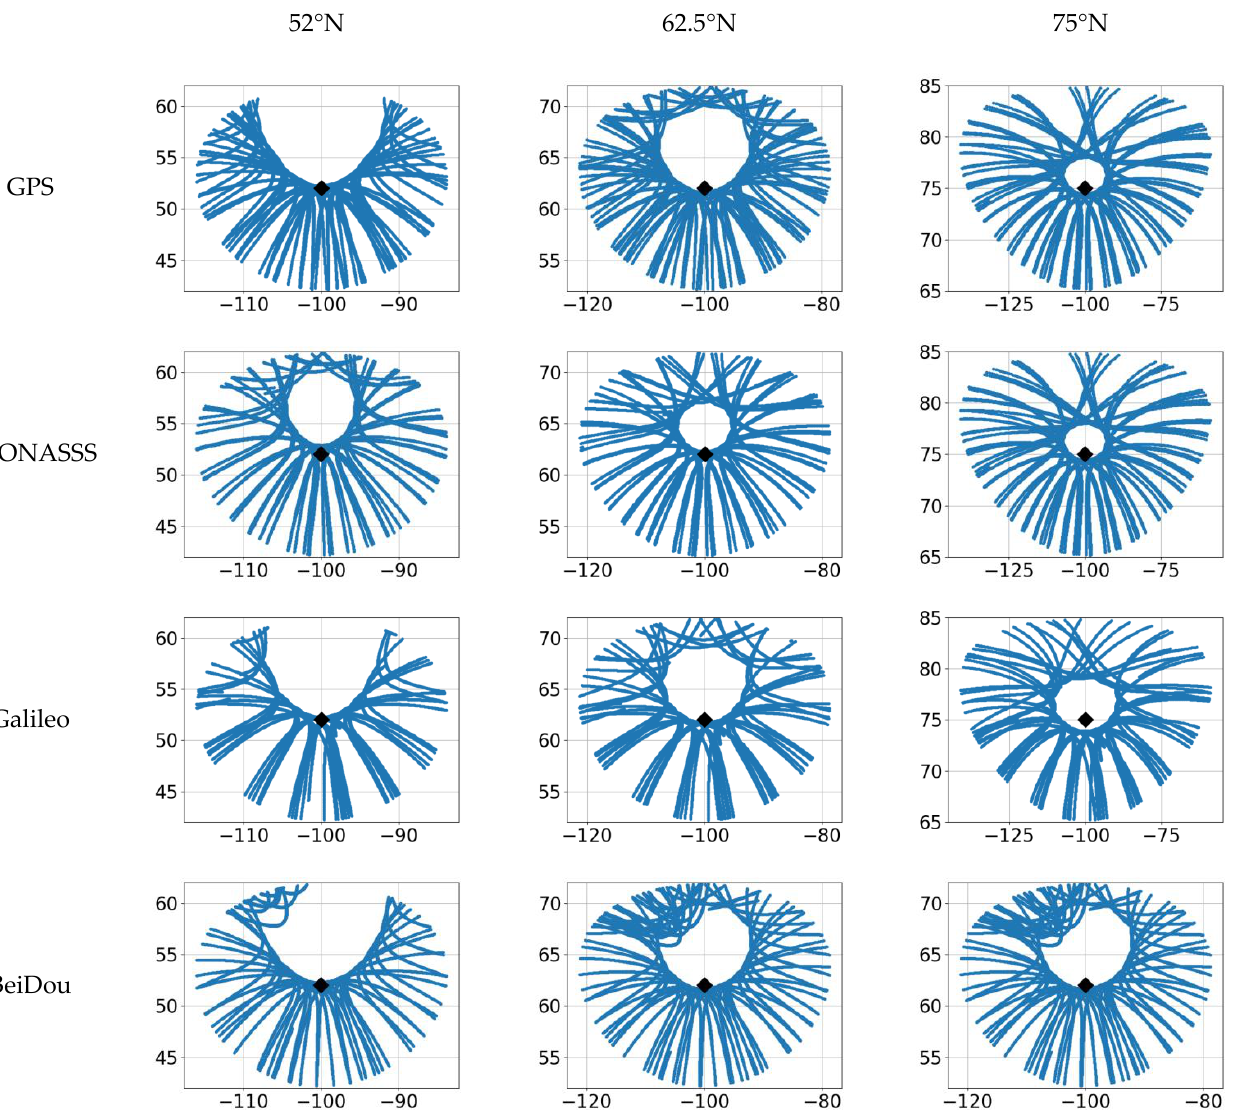
Figure 10. Diurnal ionospheric points for GPS, GLONASS, Galileo, BeiDou (top to bottom). The rhomb marks the station position. The station longitude is − 100° E. Left column: at 52.2° N, mid column: at 62.5° N, right column: at 75° N.